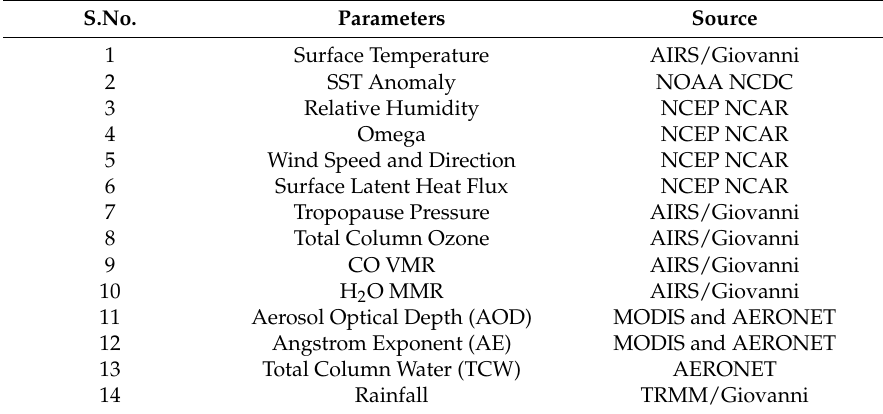
Table 3. Parameters used and source of data.